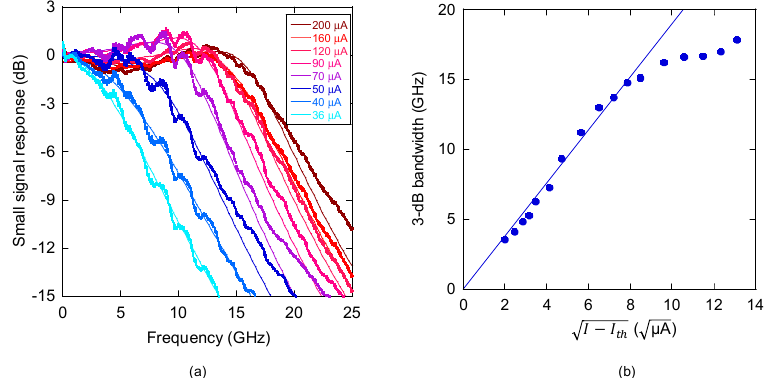
Figure 5. ( a ) Small-signal responses of the device for various bias currents ranging from 36 to 200 µ A. Fitting curves based on rate equations are also shown. ( b ) 3 dB bandwidth versus the square root of the bias current above the threshold.